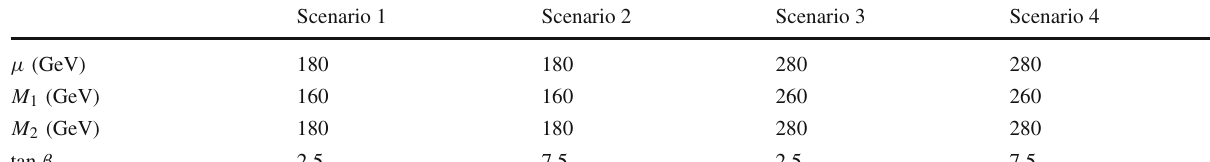
( ˜ χ) for the dominant production modes (for the LHC at 13TeV) and decay h , EFT modes of the neutralinos and charginos